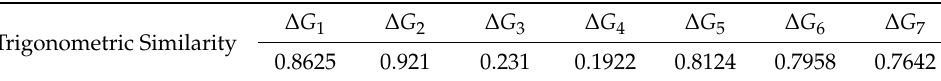
Table 3. Trigonometric function and ∆ G similarity.